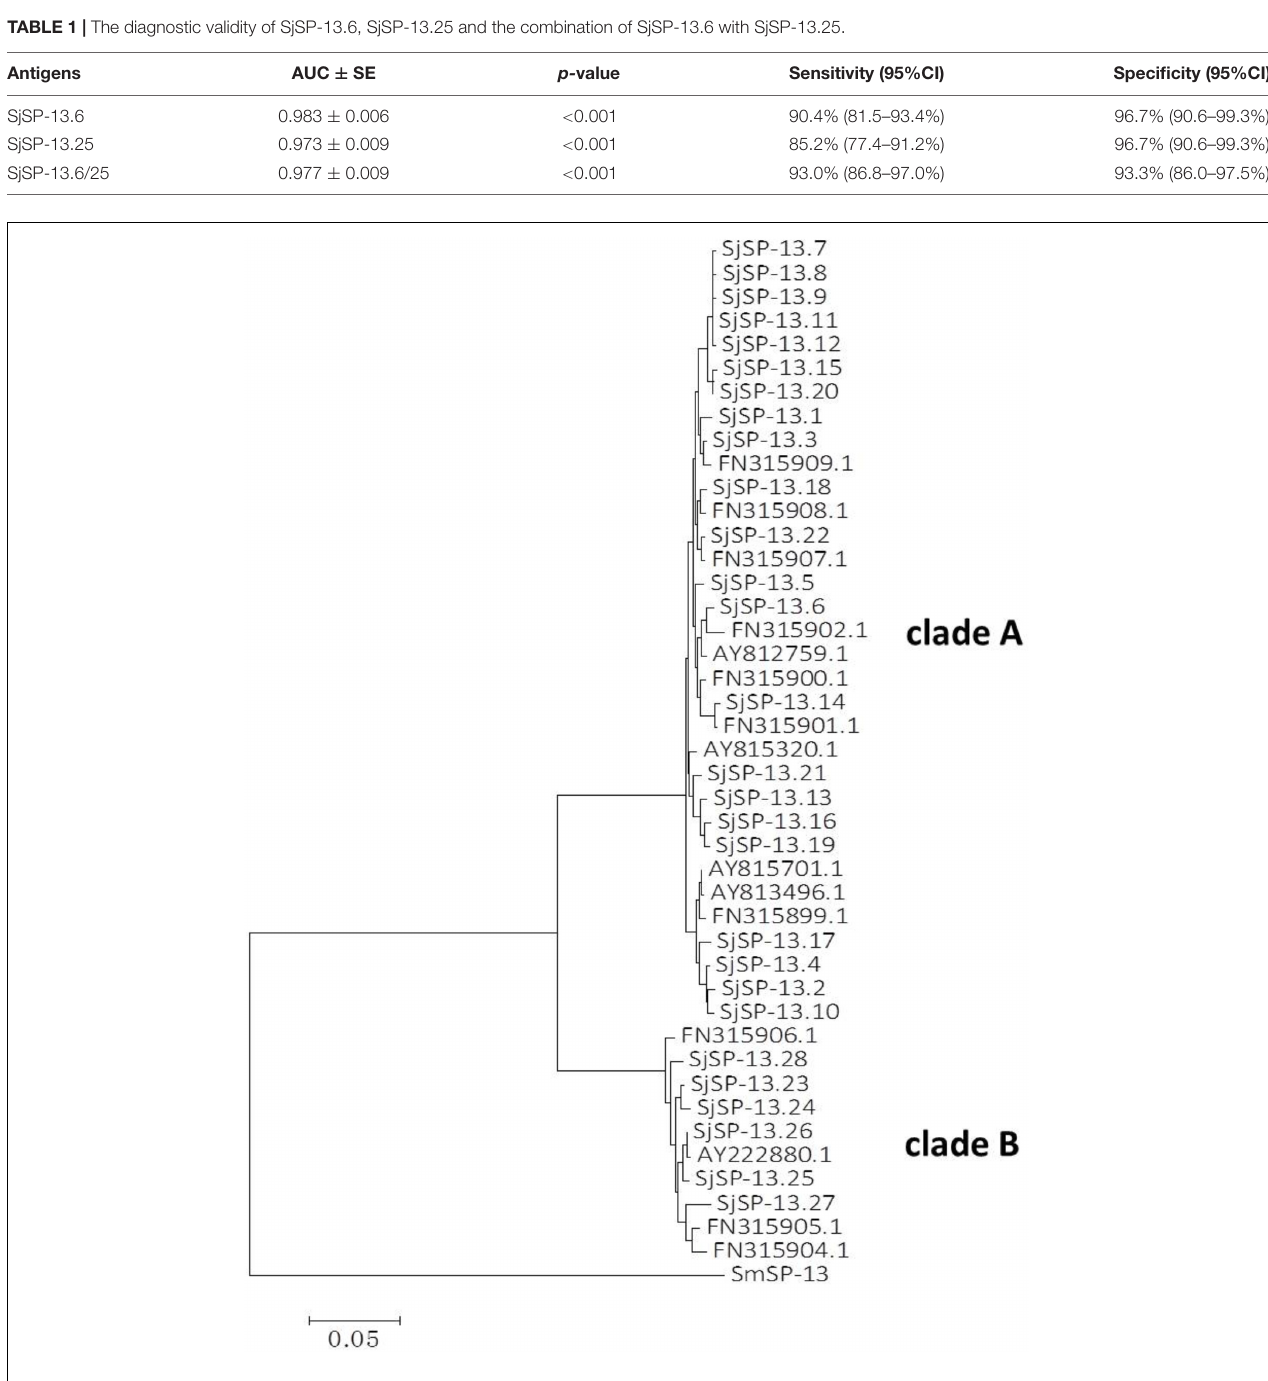
FIGURE 3 | Neighbor-joining tree of SjSP-13 alleles and SmSP-13 (AF029222) generated using Mega 5.